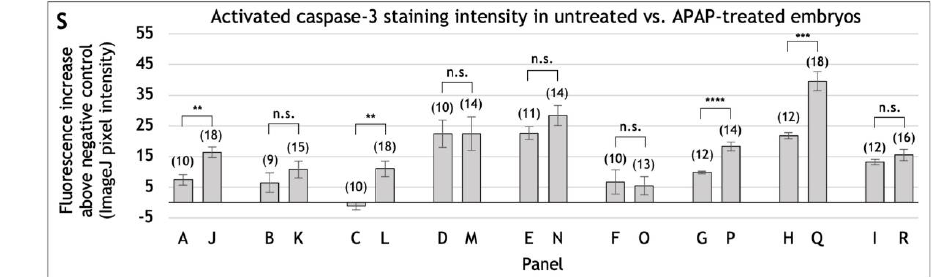
Figure 5. APAP treatment increases apoptosis in the head and pharyngeal arches before and during cartilage differentiation. Lateral and rostroventral views of the head and trunk regions in 24, 48, and 72 hpf embryos processed for anti-activated caspase-3 immunohistochemistry to detect apoptotic cells. In untreated embryos, apoptotic cells are sparsely distributed in the head and trunk (white arrowheads in ( A – C ) as examples). In APAP-treated embryos at 24 hpf ( J – L ), apoptosis is substantially increased between the eyes ( K ) and along the length of the head ( J ), in the regions where the mandibular and hyoid arches (1st and 2nd pharyngeal arches) are forming. Apoptotic cells are also increased throughout the trunk ( L ), but by 48 and 72 hpf, are similar to control levels ( O , R ). At 48 hpf, large clusters of apoptotic cells are located in the dorsal head region and throughout the eye ( M , N ). At 72 hpf, apoptotic cells are concentrated in the iris, with significant numbers also between the eyes and at the base of the head. Abbreviations: First pharyngeal arch, b1; second pharyngeal arch, b2; otic vesicle, ov. Scale bar (in ( R )) for ( A – R ), 200 µ m. ( S ): Quantification of staining intensity across samples represented in panels A-R. Lateral views of the head ( A , D , G , J , M , P ) were analyzed by measuring pixel intensity within the head region from the rostral-most portion through the otic vesicle. For ventral views of the head ( B , E , H , K , N , Q ), pixel intensity was measured within the entire head anterior to the yolk. For lateral views of the trunk ( C , F , I , L , O , R ), pixel intensity was measured within the trunk region dorsal to the yolk extension. For all images, negative control values were subtracted from actual values in order to report the overall fluorescence increase. The total number of embryos tested are in parentheses. ** = t -test at p < 0.01. *** = t -test at p < 0.001. **** = t -test at p < 0.0001. n.s. = not significant ( p > 0.05). Error bars indicate the standard error of the